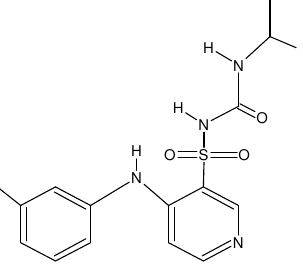
Figure 1. Structure of